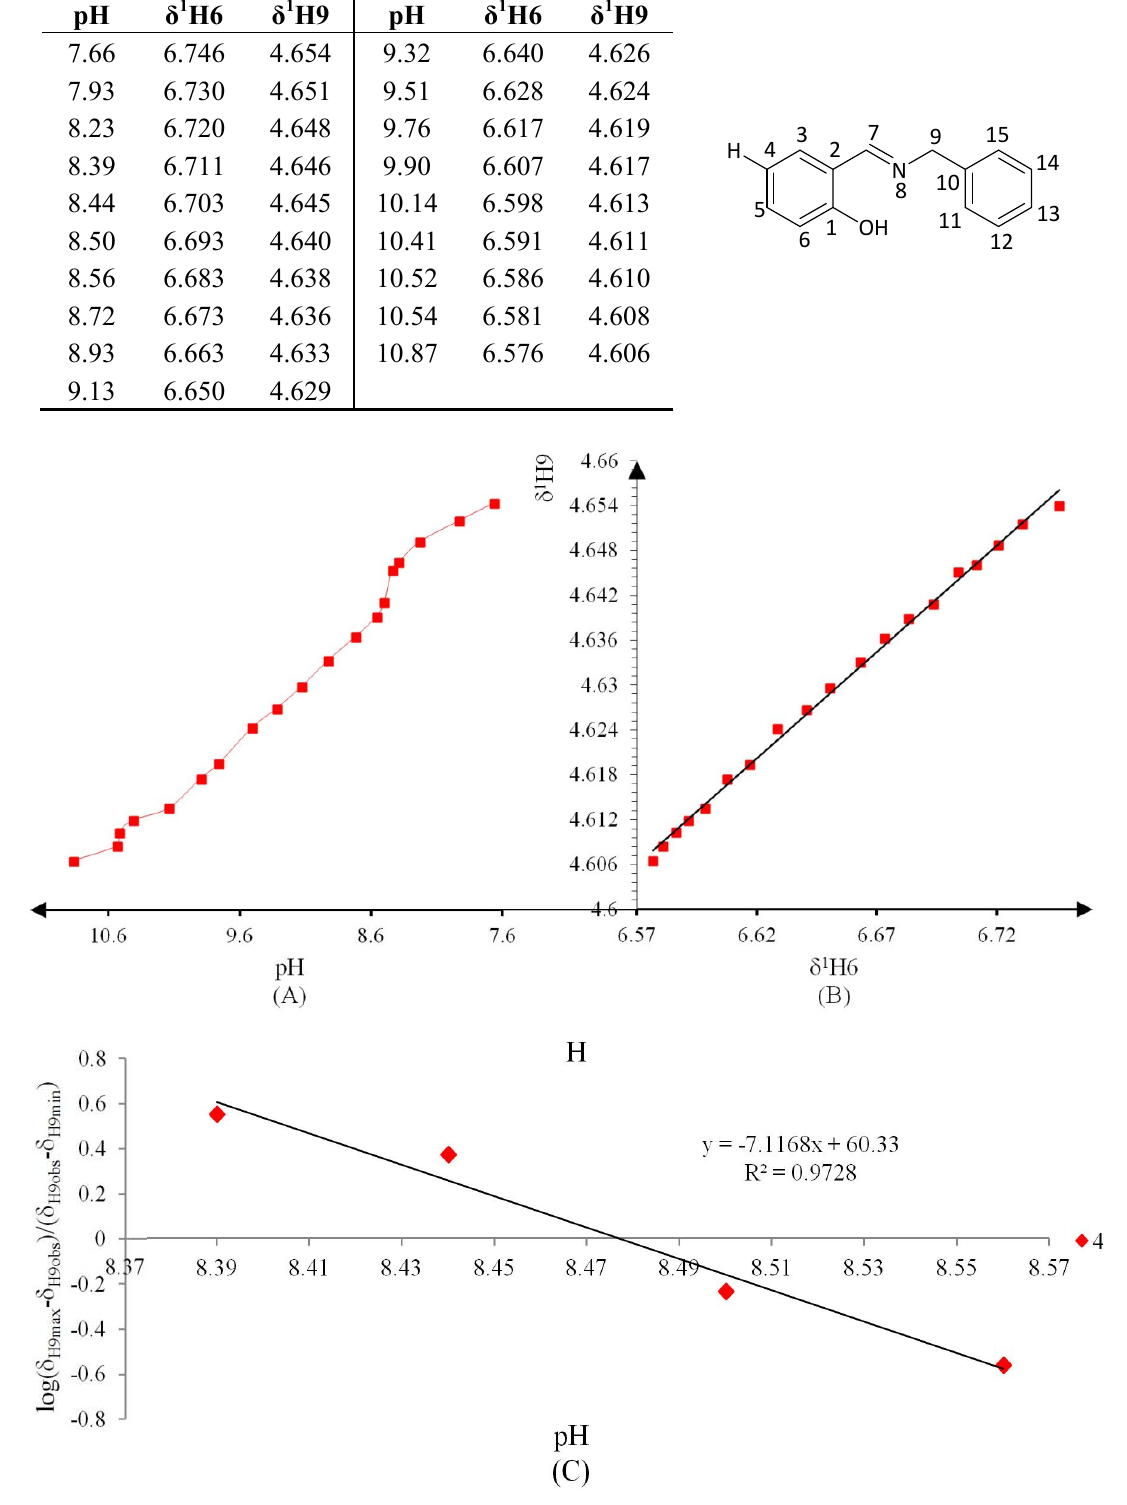
Figure 9. ( A ) titration curve (pH vs. δ 1 H9); ( B ) δ -diagram with Perrin model analysis ( 1 H6 vs. 1 H9) and ( C ) plot of the semilogarithmic Henderson-Hasselbalch equation (pH